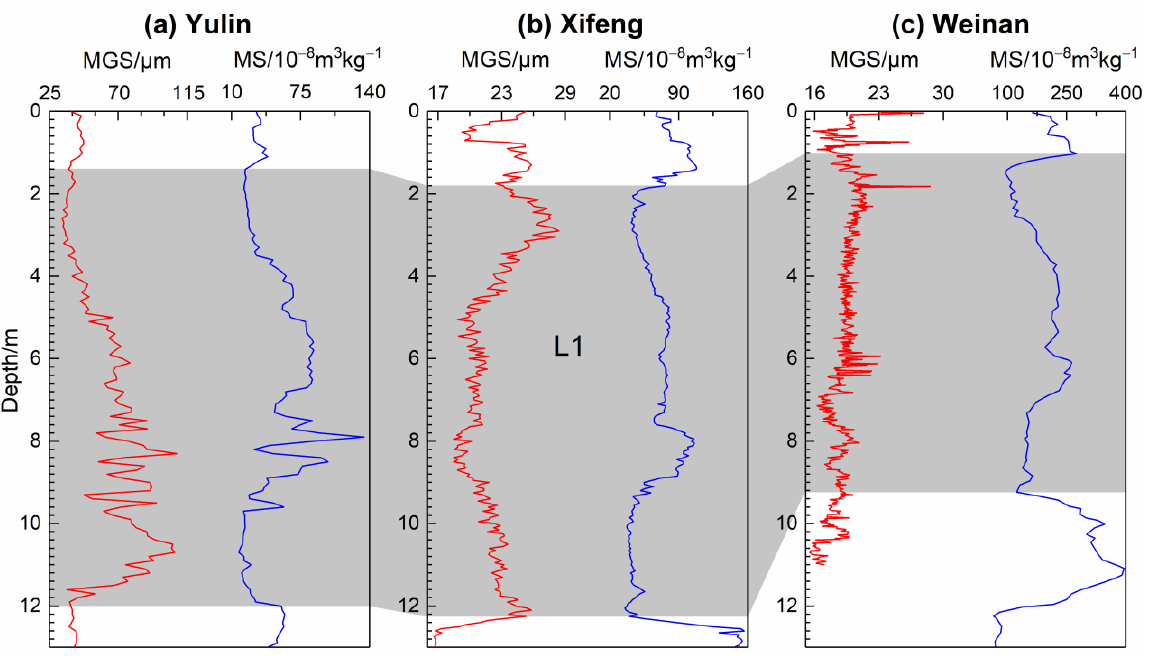
Figure 4. Variations in mean grain size (MGS; red) and magnetic susceptibility (MS; blue) of Yulin ( a ), Xifeng ( b ), and Weinan ( c ) loess sections in last glacial period. The gray area indicates last glacial loess.